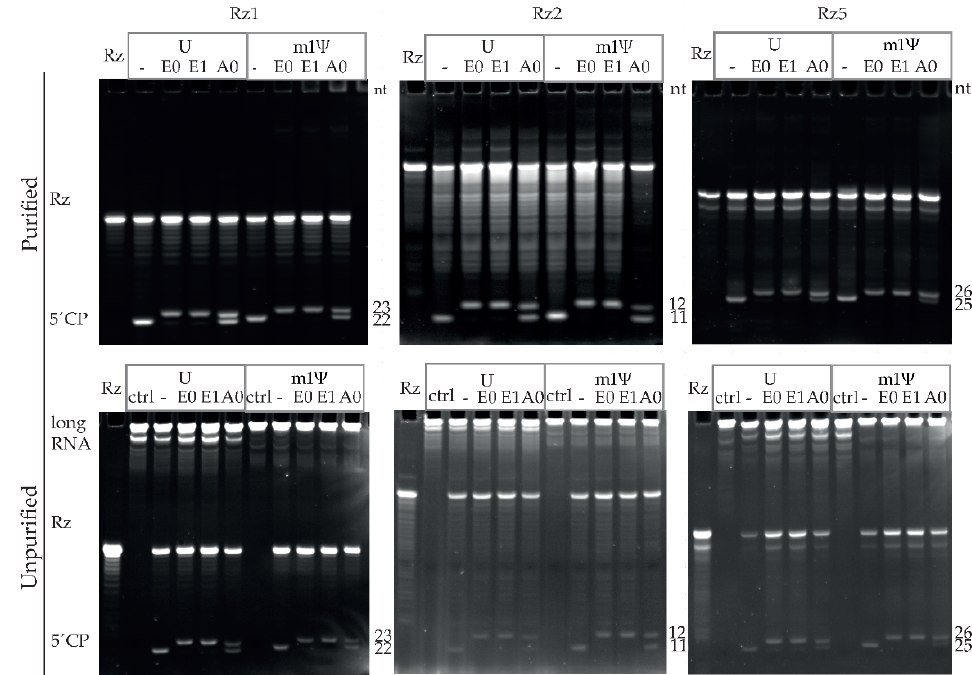
Figure 3. Ribozyme-mediated cleavage effectively assesses capping efficiencies of IVT mRNAs by visualization and quantification using denaturing polyacrylamide gel electrophoresis. Ribozyme- (Rz) mediated cleavage (using Rz1, Rz2, and Rz5) of U-containing or m1 Ψ -containing RNAs: Uncapped (-), enzymatic cap0 (E0), enzymatic cap1 (E1), and ARCA (A0) were purified on silica-based columns and then visualized using 21% PAGE, 8 M urea (purified, upper panel) or visualized using 21% PAGE, 8 M urea without silica-based column purification (unpurified, lower panel). Rz was used as a control on both the upper and lower panels, while uncleaved mRNA was in addition used as a control (ctrl) on the lower panels. 5 ′ CP: 5 ′ cleavage products (upper: Capped, lower: Uncapped); nt: Nucleotides.